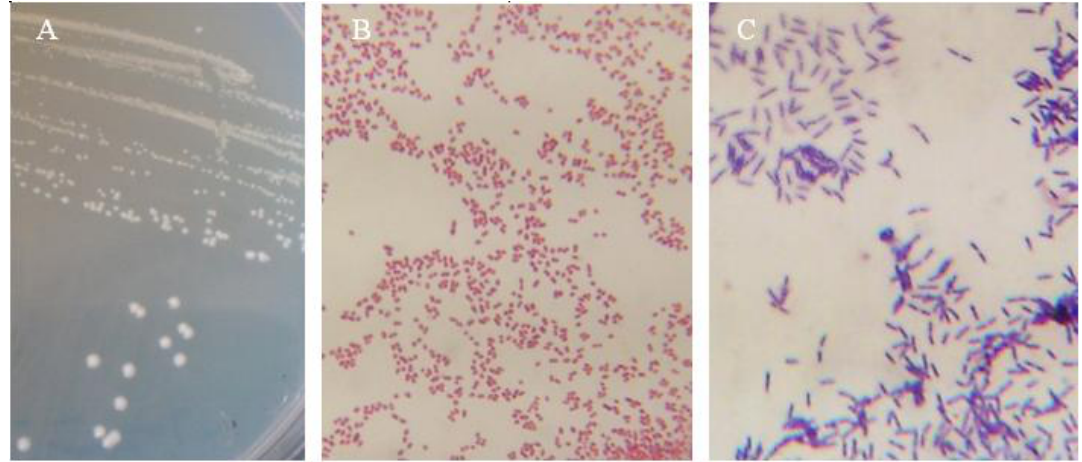
Fig 1. Colonies of pure isolate ZYM2 on RM agar (A) and rod shaped, Gram negative ZYM1 (B) and Gram positive ZYM3 (C).